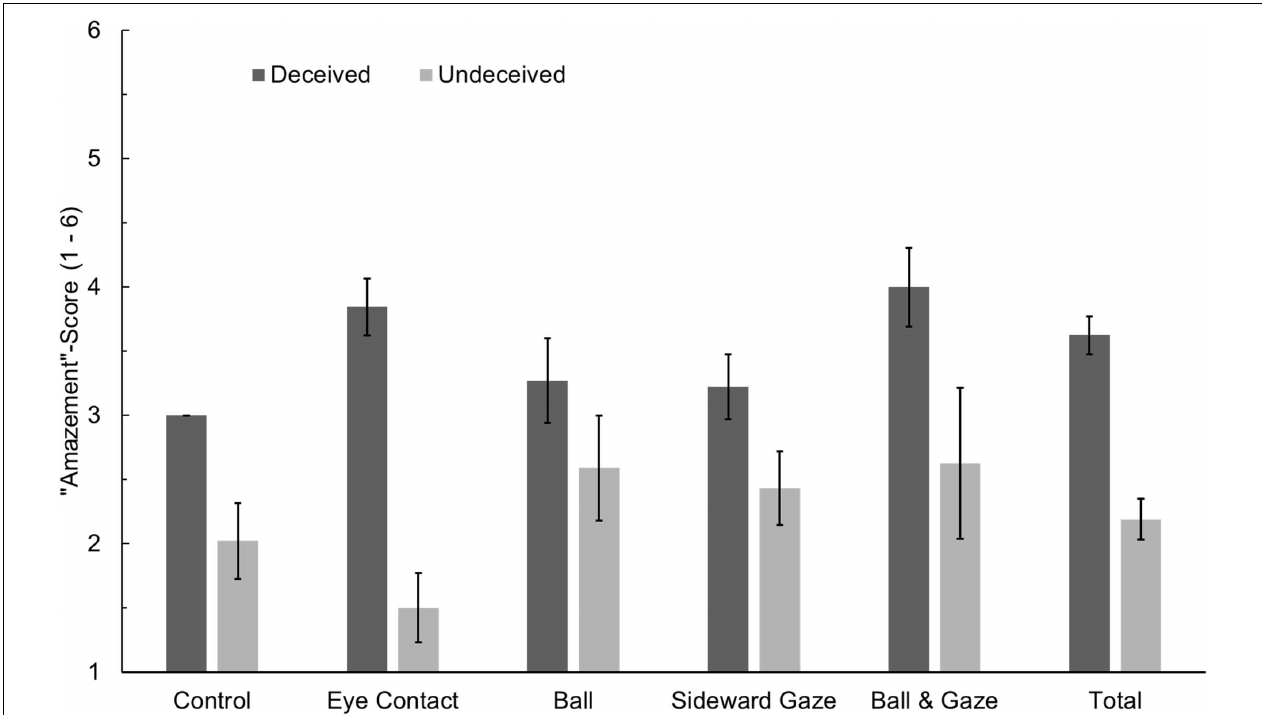
FIGURE 3 | “Amazement” scores for individuals who were deceived or undeceived during the first presentation of the video in the five experimental conditions. Error bars denote standard errors of the mean. Note that only one participant was deceived in the control group (see Table 1 ).